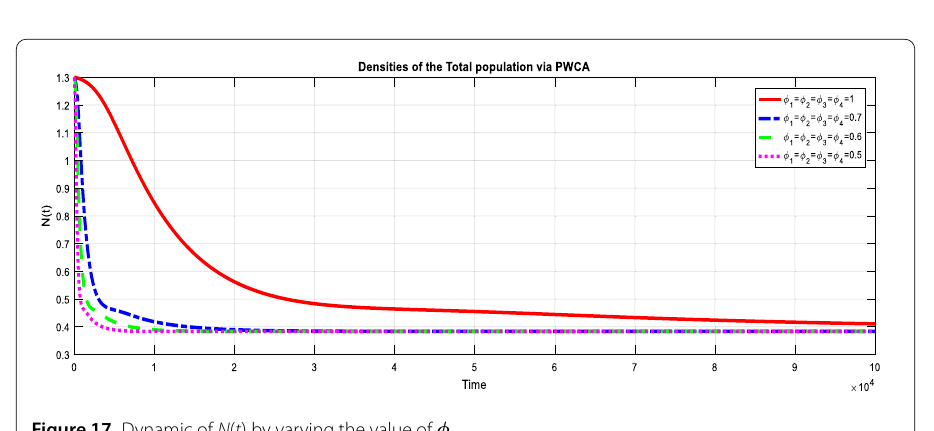
For α = 1, Eq. (25) reduces to the classical Euler